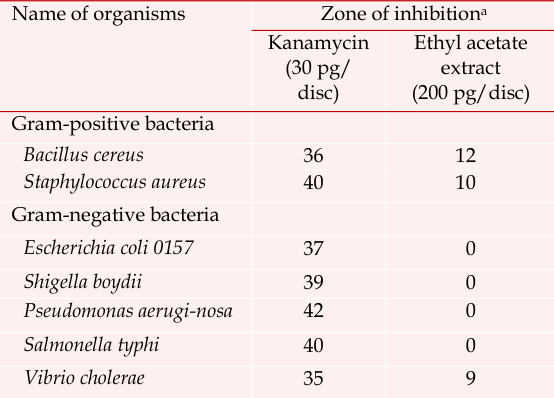
Zone of inhibition of ethyl acetate extract of AL-2 Name of organisms